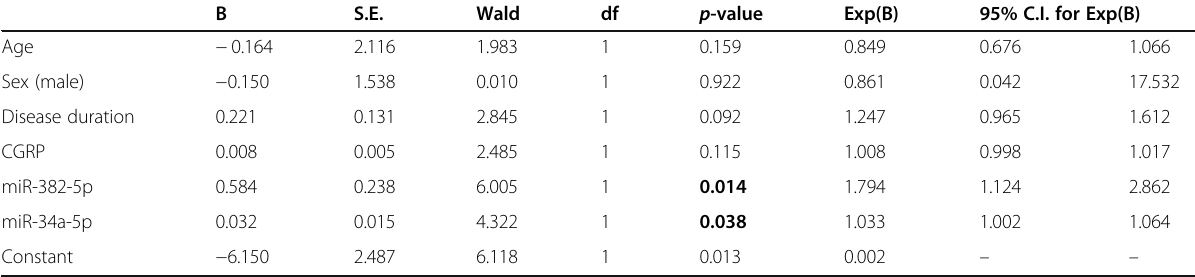
Table 2 Results of the logistic regression analysis for dependent variables: EM vs.